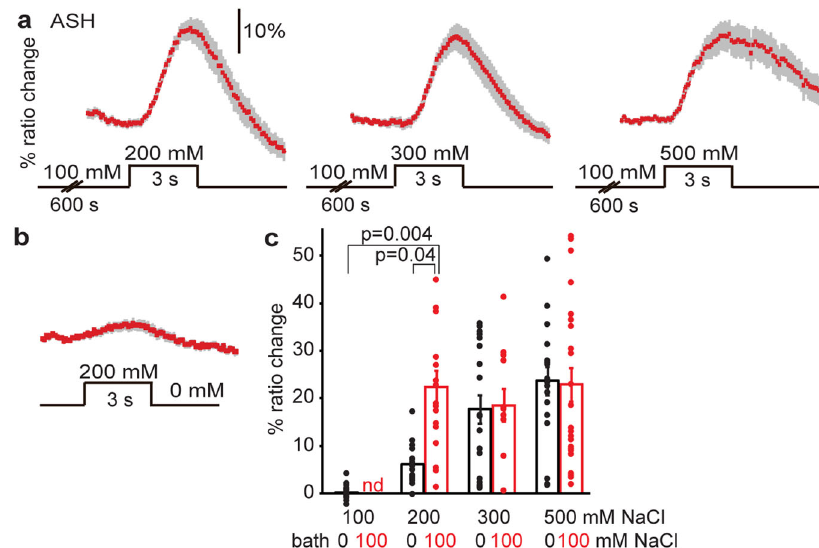
Fig. 4 Prolonged exposure to NaCl sensitizes ASH. a Average Ca 2 + transient (±SEM) in ASH in response to an increase from 100 mM NaCl (after 600 s exposure) to 200 – 500 mM NaCl. The response of ASH to 200 mM NaCl was increased after pre-exposure to 100 mM NaCl while the responses to 300 and 500 mM NaCl were unchanged. b Average Ca 2 + transients (±SEM) in ASH after exposure to 200 mM NaCl from a baseline of 0 mM NaCl (data from Fig. 1). c Average maximum ratio changes (±SEM) in ASH after exposure to 100, 200, 300, or 500 mM NaCl, in animals pre-exposed to 100 mM NaCl for 600 s, or to control condition (100 or 0 mM NaCl bath solution, respectively). Control: 100 mM: n = 18, 200 mM: n = 18, 300 mM: n = 22, 500 mM: n = 19 animals. Pre-exposed to 100 mM NaCl: 200 mM: n = 17, 300 mM: n = 12, 500 mM: n = 24 animals. Individual data points have been indicated as dots. Statistically, signi fi cant differences have been indicated. Source data underlying this fi gure are available in Supplementary Data